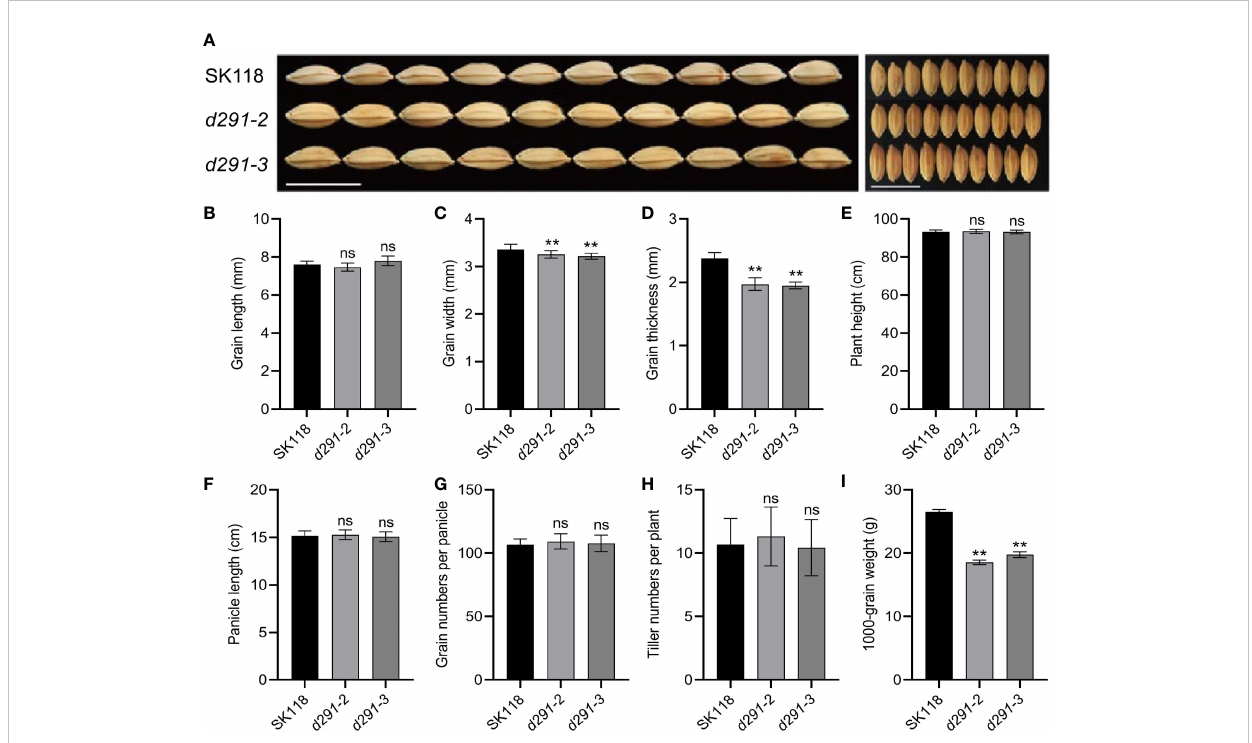
FIGURE 3 Knockout of FLOURY ENDOSPERM 2 gene has multiple effects on agronomic traits. (A) Grain phenotypes of fl o2 mutant lines ( d291-2 and d291-3 ) in SK118 background. Bar = 1 cm. (B) grain length (mm). (C) grain width (mm). (D) grain thickness (mm). (E) plant height(cm). (F) panicle length (cm). (G) grain numbers per panicle. (H) tiller numbers per plant. (I) 1000-grain weight (G) . Data are given as the mean ± S.D. (n ≥ 20). Student ’ s t test: **P < 0.01; ns, not signi fi